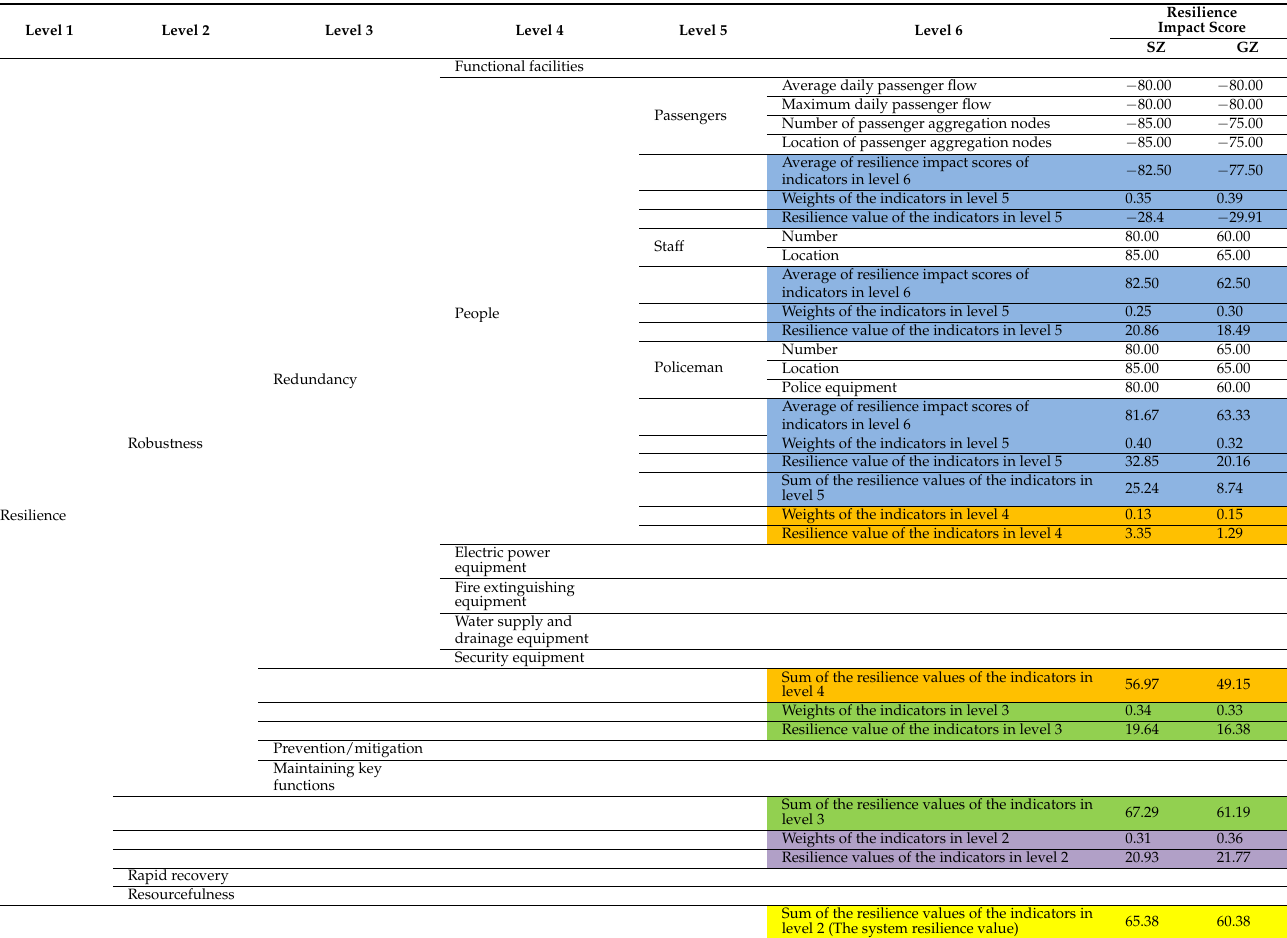
Table 4. A sample of the system resilience value calculation